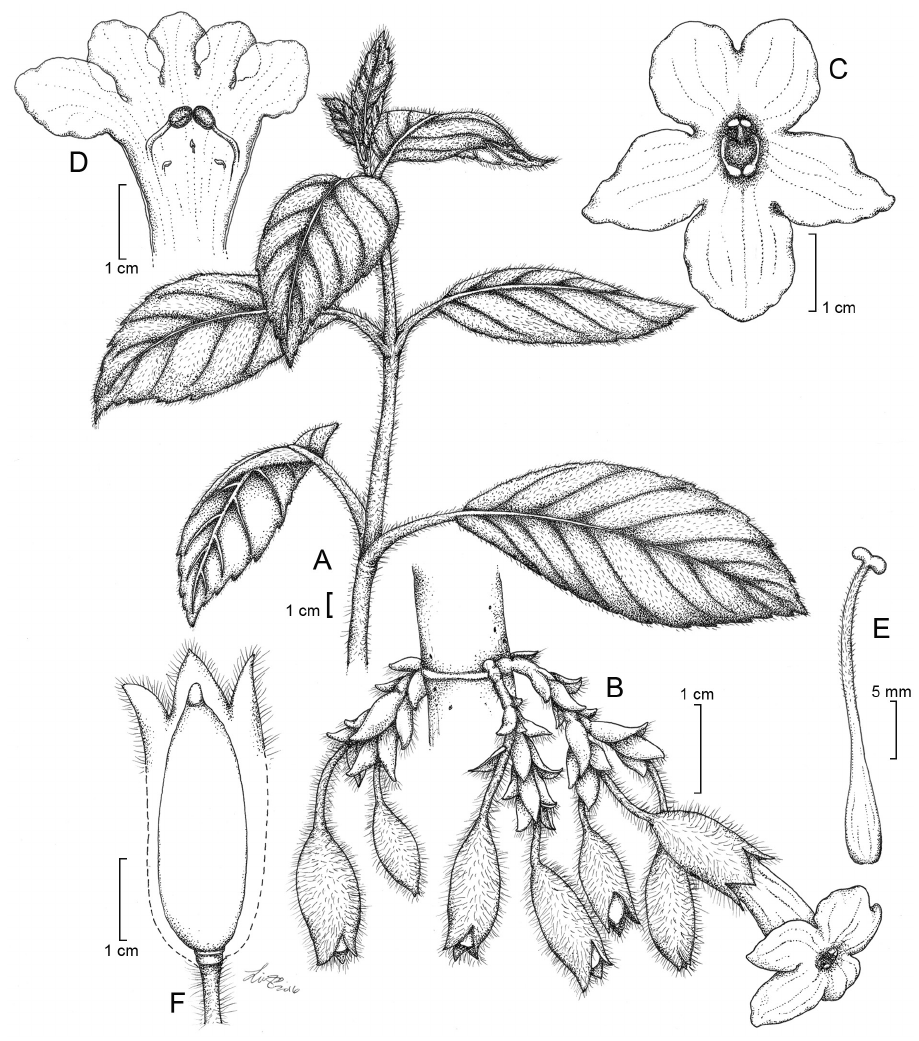
Figure 10. Cyrtandra waisaliensis M.A.Johnson. A Habit B Cauliflorous inflorescence C Corolla, an- terior view D Corolla, longitudinal section E Gynoecium F Calyx, longitudinal section and young fruit. Drawn from Johnson 48 (RSA), Johnson 50 (SUVA, RSA), and field